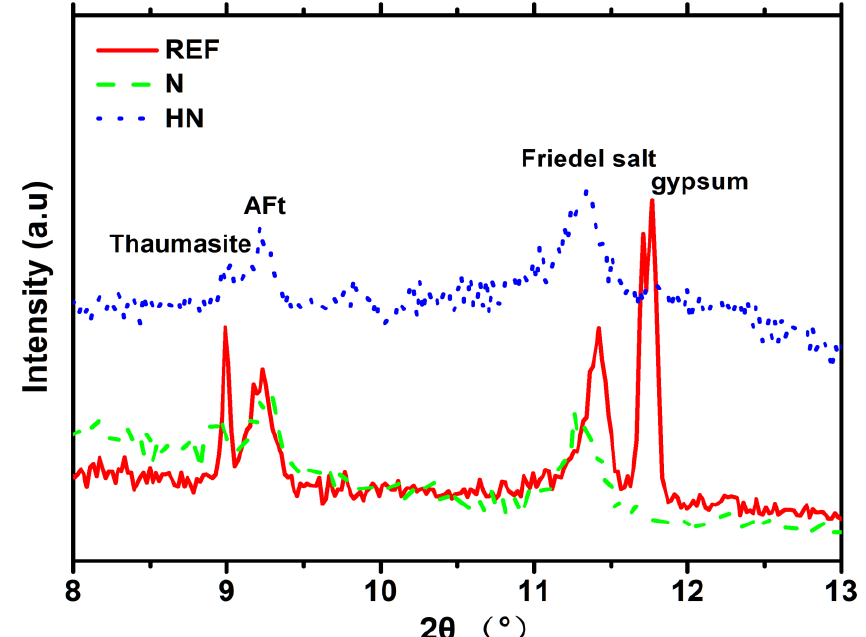
Figure 4. XRD patterns of specimen near the peak of Friedel’s salt.